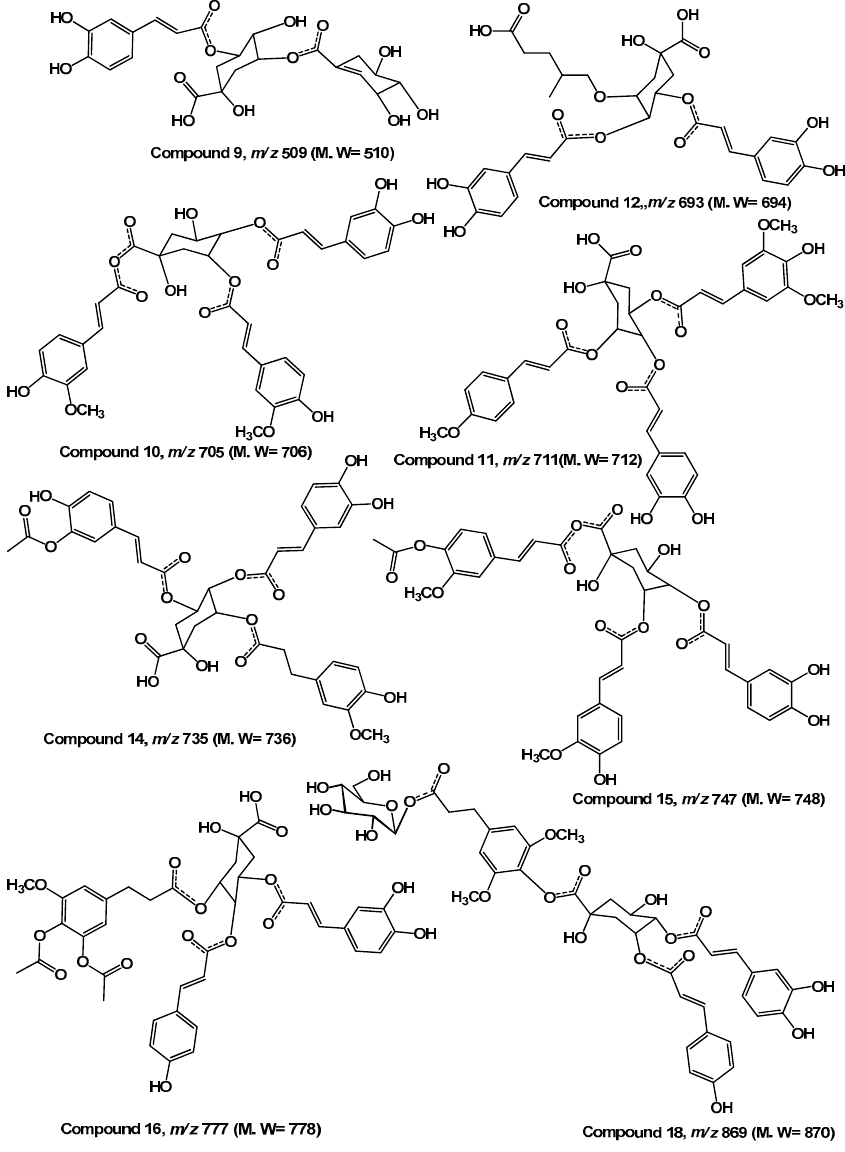
Figure 4. Proposed structures of the some phenolic compounds in Phoenix dactylifera male flowers.